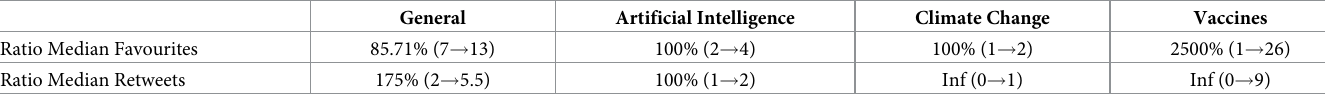
Table 5. (Twitter) percentage changes in terms of engagement with posts. The increase/decrease is reported within